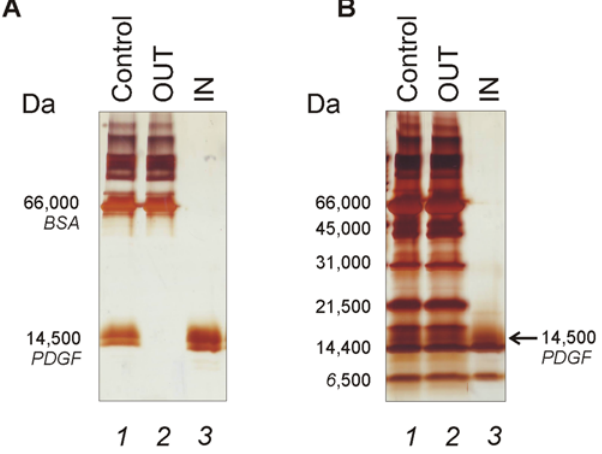
Figure 4. SDS-PAGE Analysis of PDGF incubated particles. (A) Lane 1) Starting solution containing BSA and PDGF (Control), 2) Supernatant (OUT); 3) Particle content (IN). Particles remove PDGF from carrier albumin with a total exclusion of albumin itself. (B) Lane 1) Starting solution containing PDGF, BSA, aprotinin (MW 6,500 Da), lysozyme (MW 14,400 Da), trypsin inhibitor (MW 21,500 Da), carbonic anhydrase (MW 31,000 Da), and ovalbumin (MW 45,000 Da) (Control), 2) Supernatant (OUT); 3) Particle content (IN). Particles harvest PDGF together with low molecular weight proteins and exclude proteins above ca 20,000